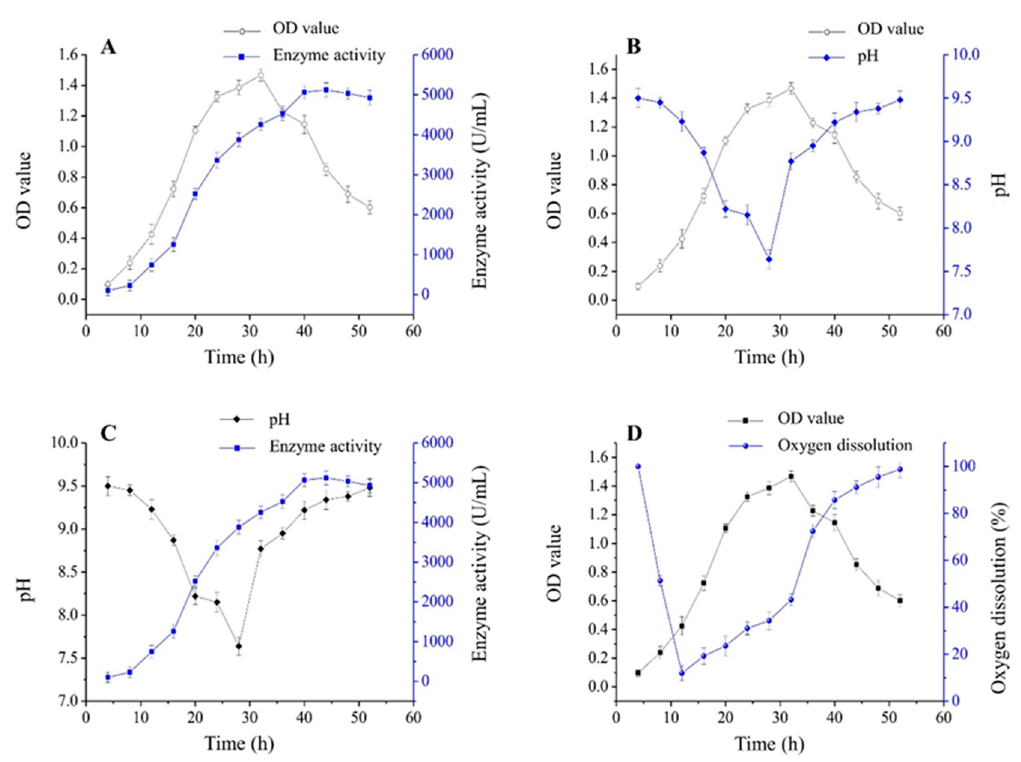
Figure 5. Biomass, enzyme activity, pH, and oxygen dissolution during cultivation of palm curtain immobilized Bacillus circulans ATCC 21783 in a 5 L tank ( A ) relation of biomass and enzyme activity; ( B ) relation of biomass and pH; ( C ) relation of enzyme activity and pH; ( D ) relation of biomass and oxygen dissolution.